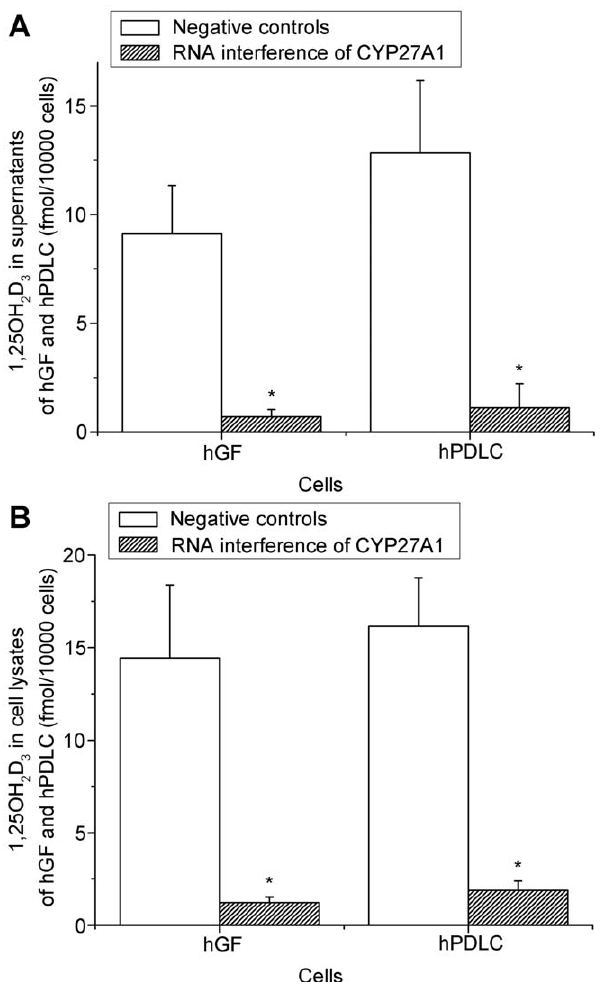
Figure 7. The effect of 25-hydroxylase knockdown on 1,25OH 2 D 3 generation. hGF and hPDLC from donors 2, 4 and 5 were treated with 1000 nM vitamin D 3 for 48 h after transfection with a siRNA oligonucleotide for CYP27A1 or a non-silencing control, and 1,25OH 2 D 3 production was measured in supernatants(A) and cell lysates (B). When CYP27A1 was knocked down, the generation of 1,25OH 2 D 3 decreased significantly compared to when CYP27A1 was not knocked down. The data are presented as the mean 6 SE. * hGF or hPDLC generated significantly less 1,25OH 2 D 3 with 1000 nM vitamin D 3 when CYP27A1 was knocked down ( p , 0.05). concentration was determined using the Bicinchoninic Acid Protein Assay Kit (Applygen, Beijing, China). Twenty micrograms of total protein from each sample were loaded onto a gel comprising a 5% (w/v) stacking gel and a 10% (w/v) running gel. At the end of the electrophoresis, samples were transferred onto nitrocellulose blotting membranes (Hybond TM ; Amersham Phar- macia, Little Chalfont, UK). Blots were probed with a goat